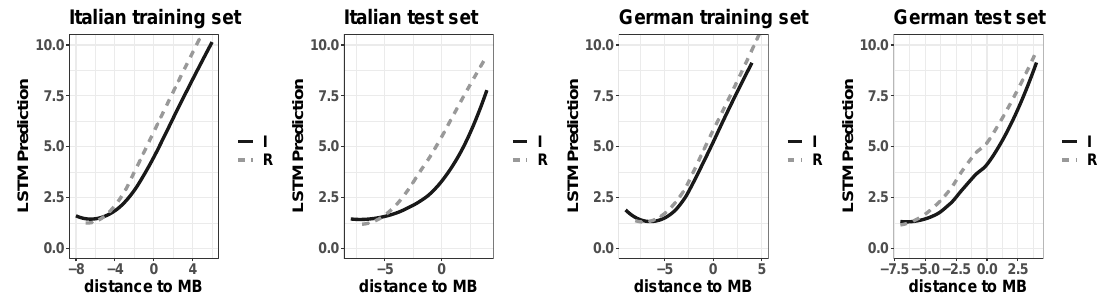
Figure 5. Regression plots of interaction between morphological (ir)regularity (Regulars versus Irregulars) and distance to morpheme boundary (MB) in non-linear models (GAMs) fitting the incremental number of correctly predicted symbols by the trained LSTMs on Italian ( left plots ) and German ( right plots ) for training and test